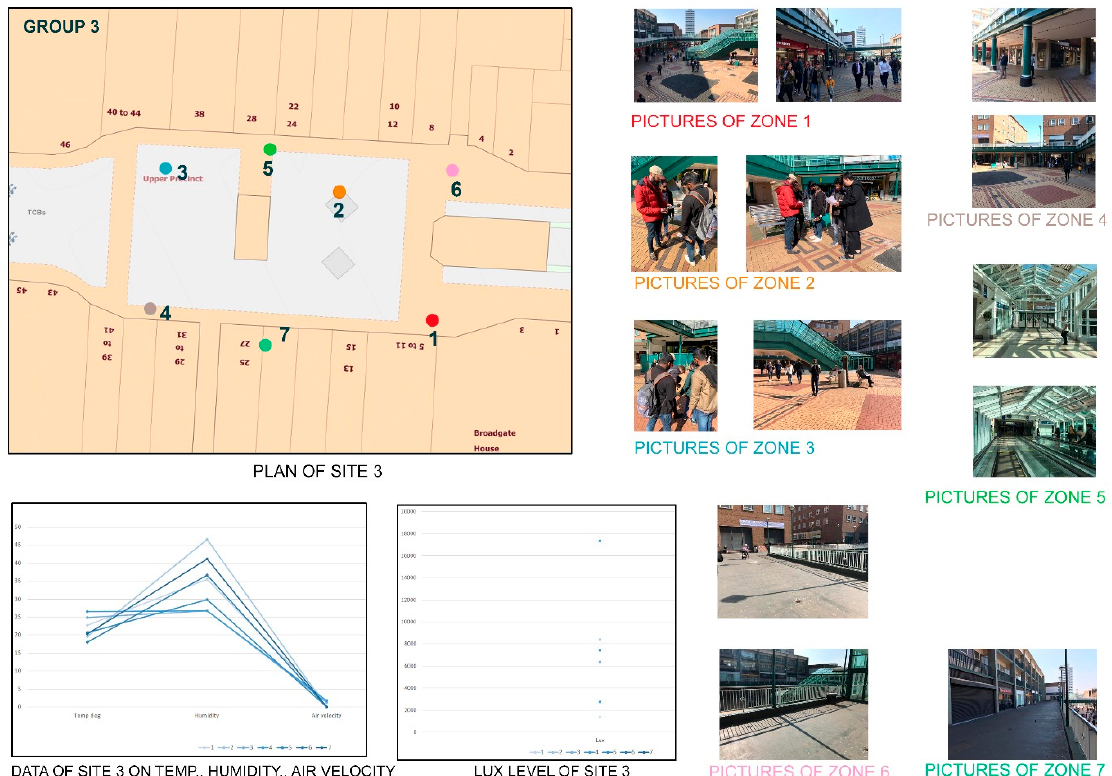
Figure 1. An example of a student project to explore outdoor thermal comfort. Master of architecture students used questionnaires and data loggers in the city centre of Coventry, UK.